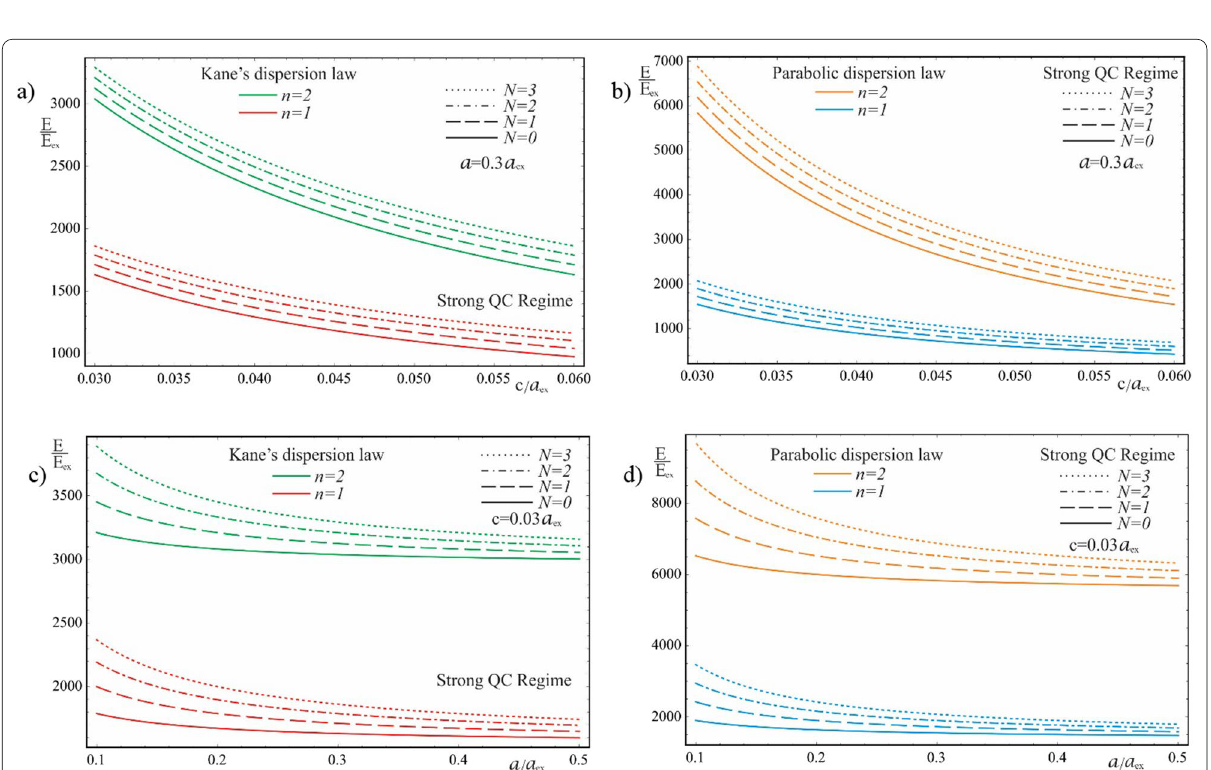
Fig. 2 The dependences of the lower two families of levels of the energy spectrum of an electron in a strongly flattened ellipsoidal QD with the Kane’s and parabolic dispersion laws of CCs: ( a ) and ( b ) on the minor semiaxis c at the fixed value of the major semiaxis a , ( c ) and ( d ) on the major semiaxis a at the fixed value of the minor semiaxis